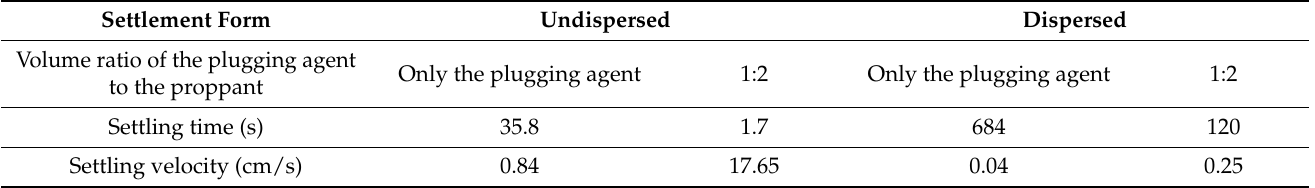
Figure 14. Settlement of the plugging agent and proppant (density = 2.00 g/cm 3 ) in the guanidine gum solution. Table 7. Sedimentation rates of the plugging agent and proppant (density = 1.15 g/cm 3 ) in water.